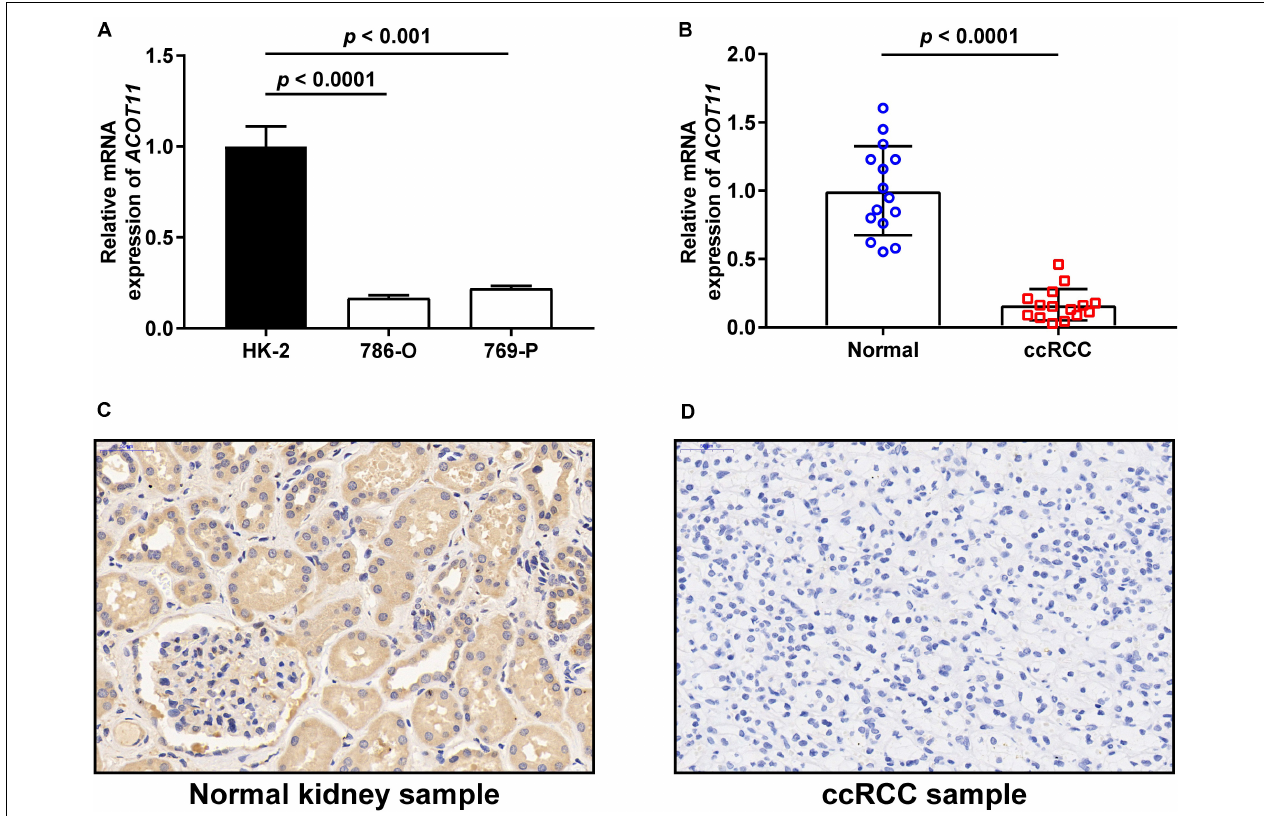
FIGURE 3 | Validation of ACOT11 expression in ccRCC by in vitro and in vivo experiments. The mRNA expression of ACOT11 in ccRCC were verified in cell lines (A) and clinical samples (B) by qRT-PCR. The protein level of ACOT11 in ccRCC were verified in clinical samples by immunohistochemistry staining (C,D) . p- Value < 0.05 was considered to be statistically